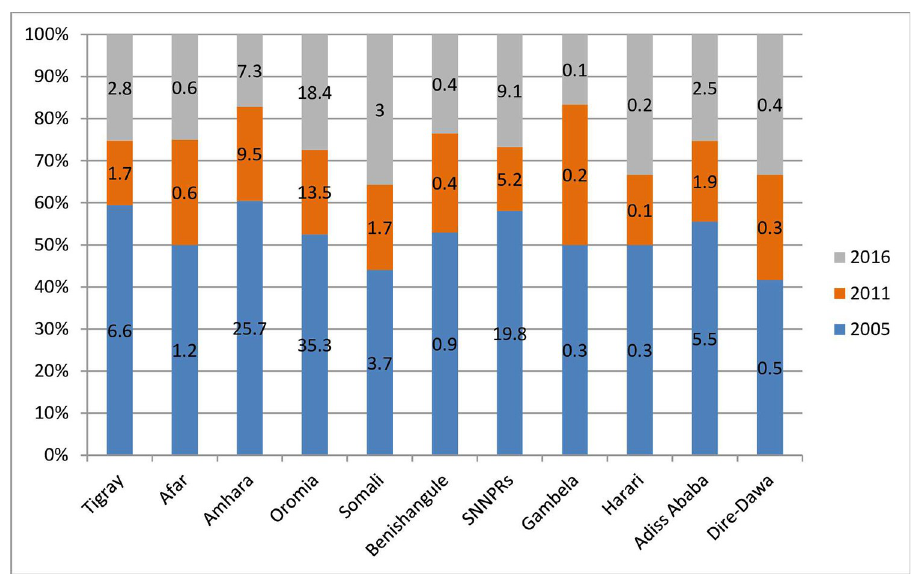
Fig 4. Regional difference in anaemia among reproductive age group from